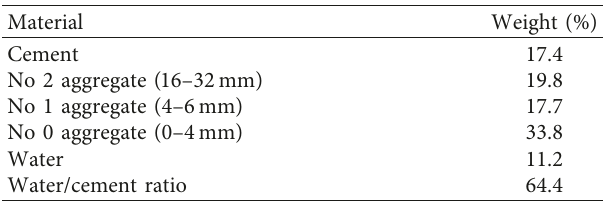
Figure 3: Design of reinforced concrete beam-column for Samples 1 to 4. Table 2: Mix composition of 1m 3